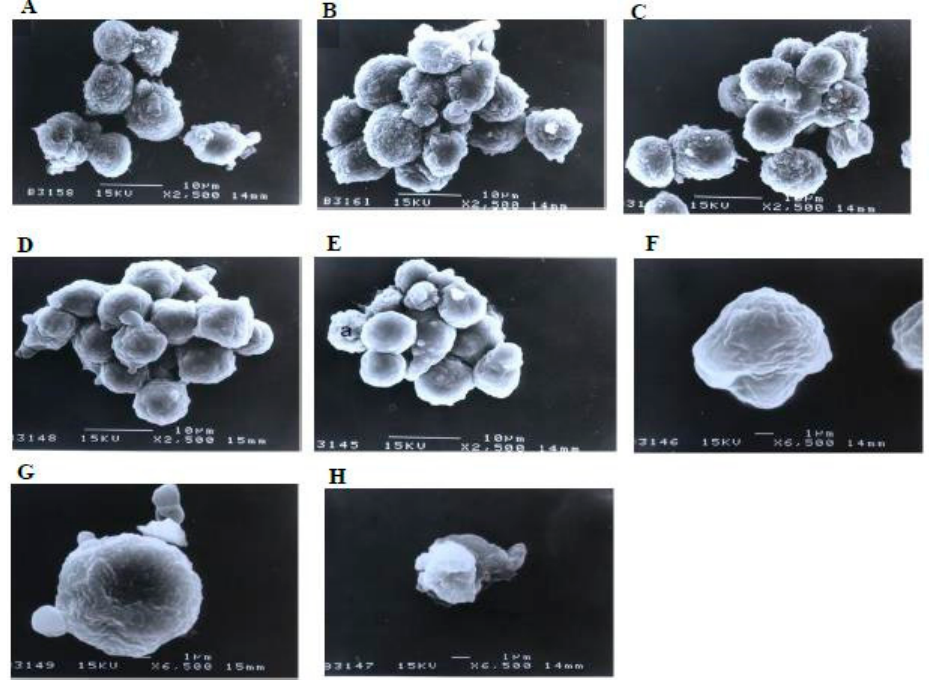
Figure 9. Scanning electron micrographs of CEM-SS cells ( A ) without (control) or treated with ( B ) 1 µ g/mL, ( C ) 3 µ g/mL, ( D ) 10 µ g/mL, or ( E ) 30 µ g/mL of damnacanthal for 24 h (2500 × magnification). ( F – H ) are close-up views of cells treated with 10 µ g/mL and 30 µ g/mL, respectively, of the compound (6500 × magnification). a: apoptotic cell.